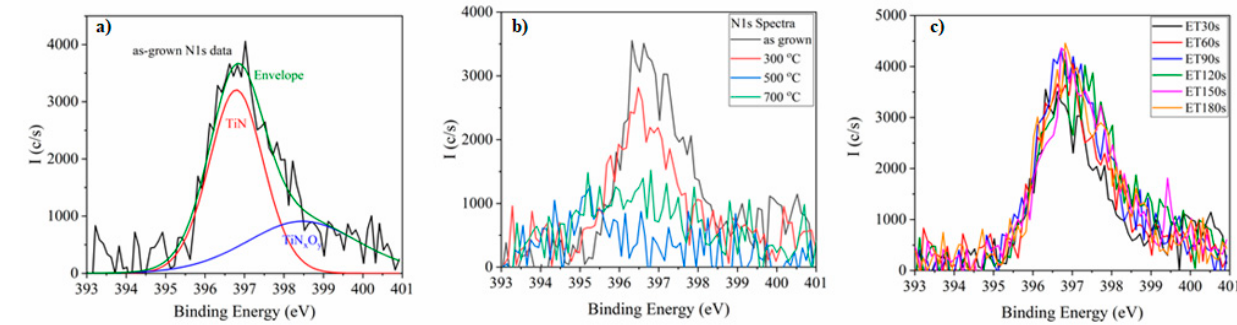
Figure 5. ( a ) High resolution XPS spectrum of N1s of as-grown TiN film; by peak fitting the spectrum is deconvoluted in TiN and TiN x O y peaks. ( b ) High resolution XPS spectra of N1s of as-grown and annealed TiN films, taken after 30 s etching. ( c ) High resolution XPS spectra of N1s of as-grown TiN film, taken at different etching levels.